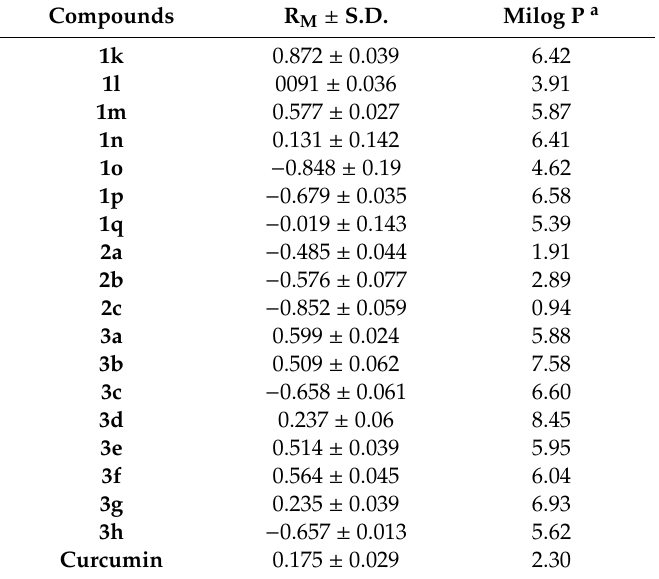
Table 1. Experimentally determined lipophilicity values (R M